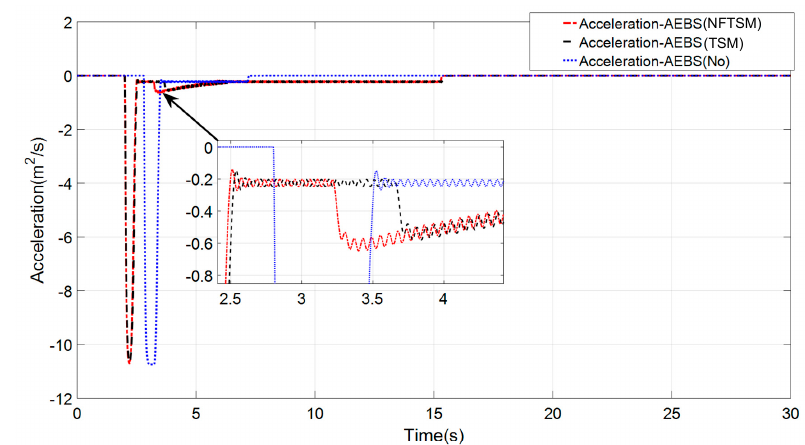
Figure 19. Comparison of vehicle acceleration.